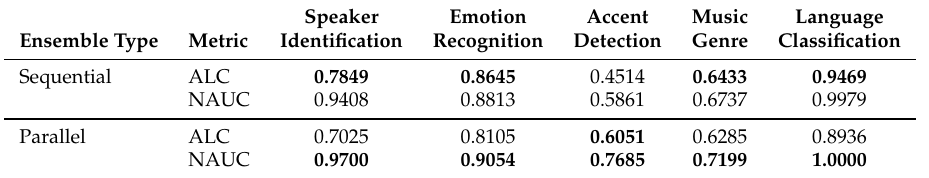
Table 8. Audio: Performance of a sequential and a parallel ensemble on the training